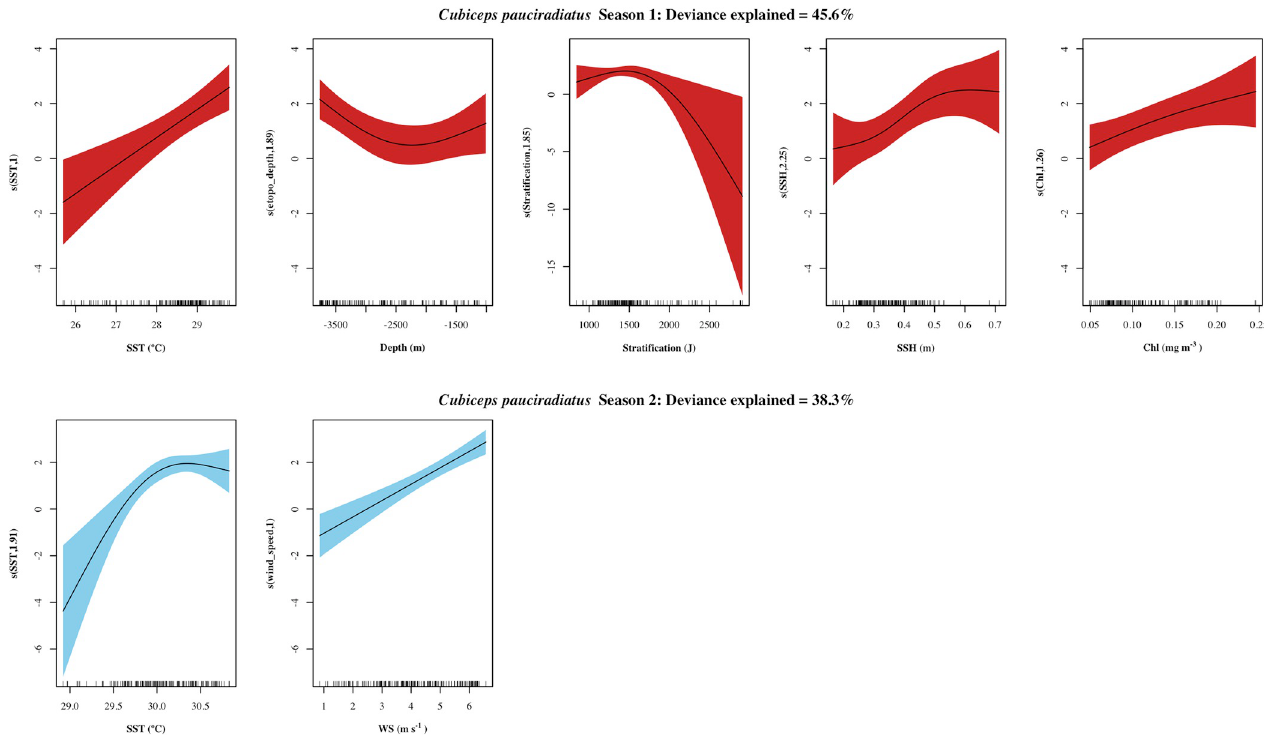
Fig 6. Response plots of the oceanographic variables’ additive effect on the density of Cubiceps pauciradiatus . Season I (April-July) in red and season II (August-October) in blue. Smoothed values represented by a continuous line, and shaded color indicates 95% confidence intervals. variables with non- significant additive effects (p > 0.05) for a given season are not presented. Y axis scale in season I plots were modified to allow for a better interpretation.